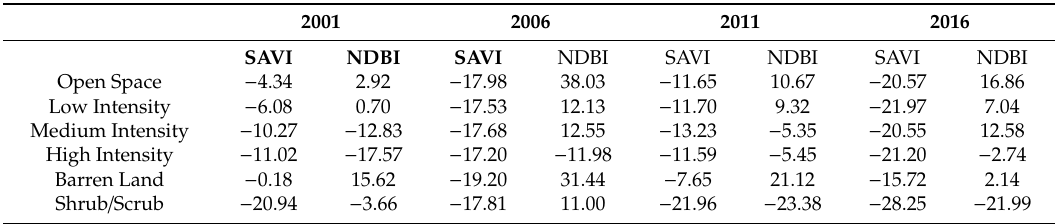
Table 4. Averaged coe ffi cient estimates by land use land cover (LULC) type for 2001, 2006, 2011, and